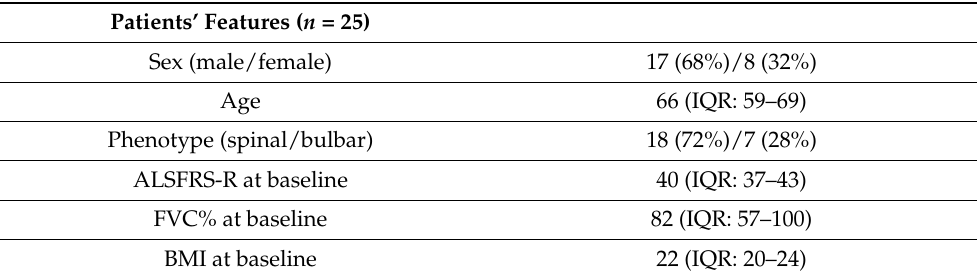
Table 1. Demographic and phenotypic features of ALS patients. Numbers are expressed as number, percentage or median, and interquartile range (IQR) as required. ALSFRS-R: Amyotrophic Lateral Sclerosis Functional Rating Scale—Revised; FVC: forced vital capacity; BMI: body mass